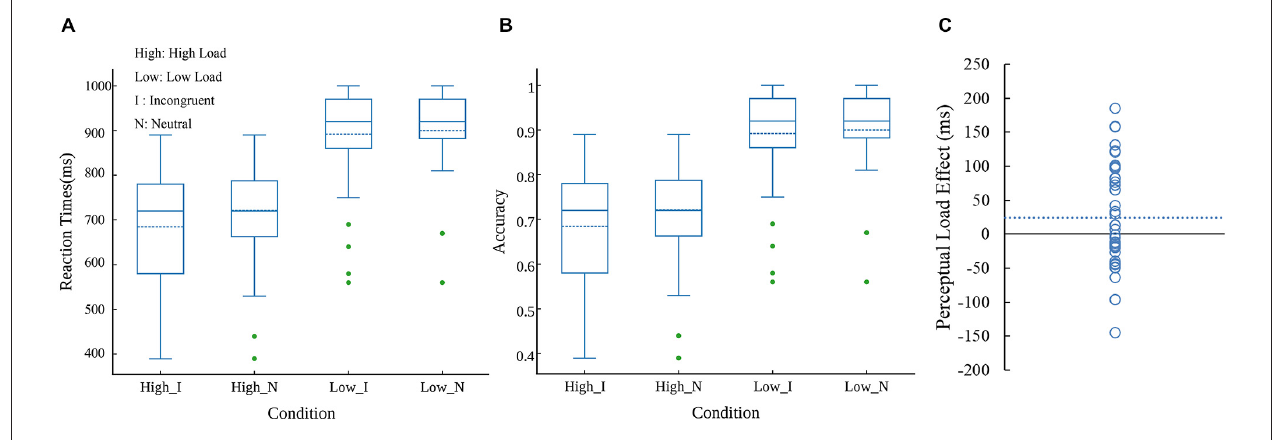
Individual differences related to PLE (without normalization) (C) . Each circle represents one participant’s score in PLE. The dash line reflect mean